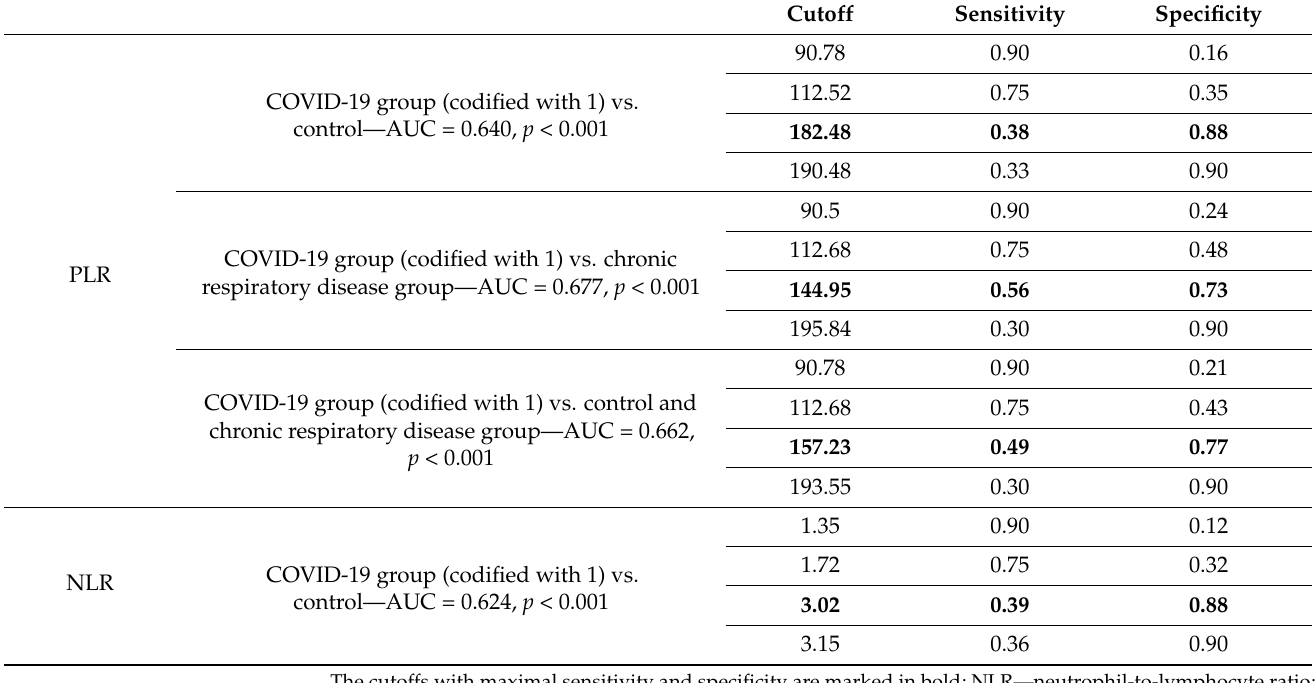
Table 2. Performance of PLR and NLR in the case when statistically significant difference in ROC curve was reached. Cutoff Sensitivity Specificity